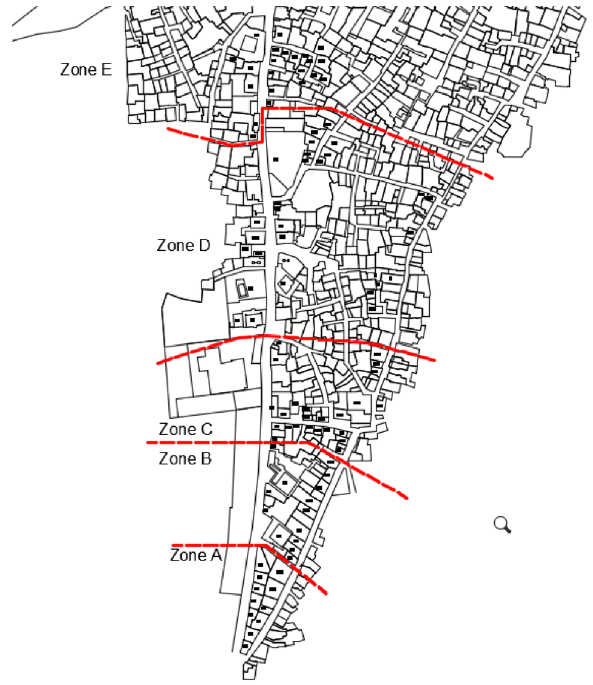
Fig. 4 Distribution of zones at studied